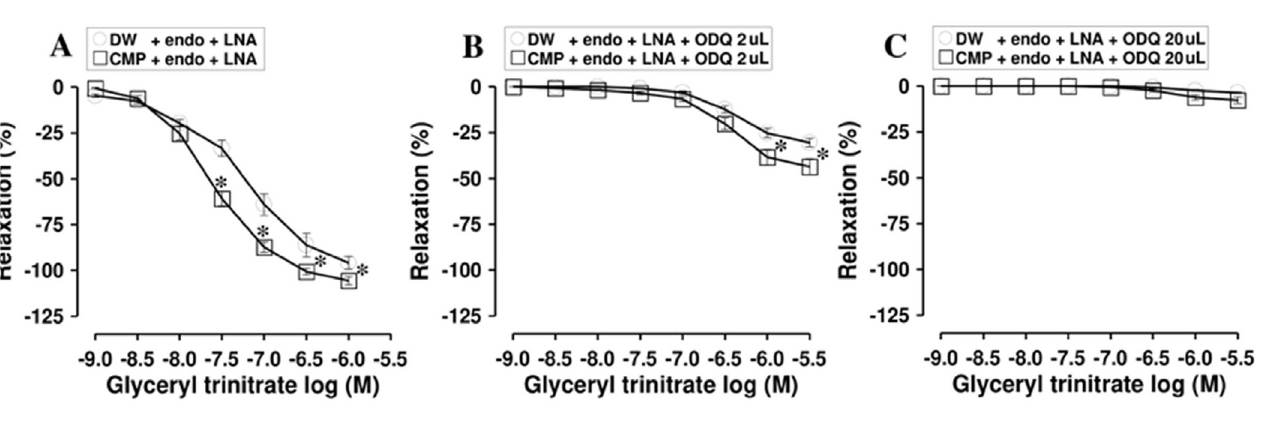
FIGURE 7 - Effects of CMP (1 g/kg) or distilled water (DW, control) consumption by the middle-aged male rats on relaxation of the endothelium-intact thoracic aortic ring precontracted with phenylephrine to glyceryl trinitrate in the presence of (A) L-NA, (B) L-NA and 1 μM ODQ and (C) L-NA and 10 μM ODQ. Values represent mean ± SEM; n = 6. * Significantly lower than the DW control group, P <